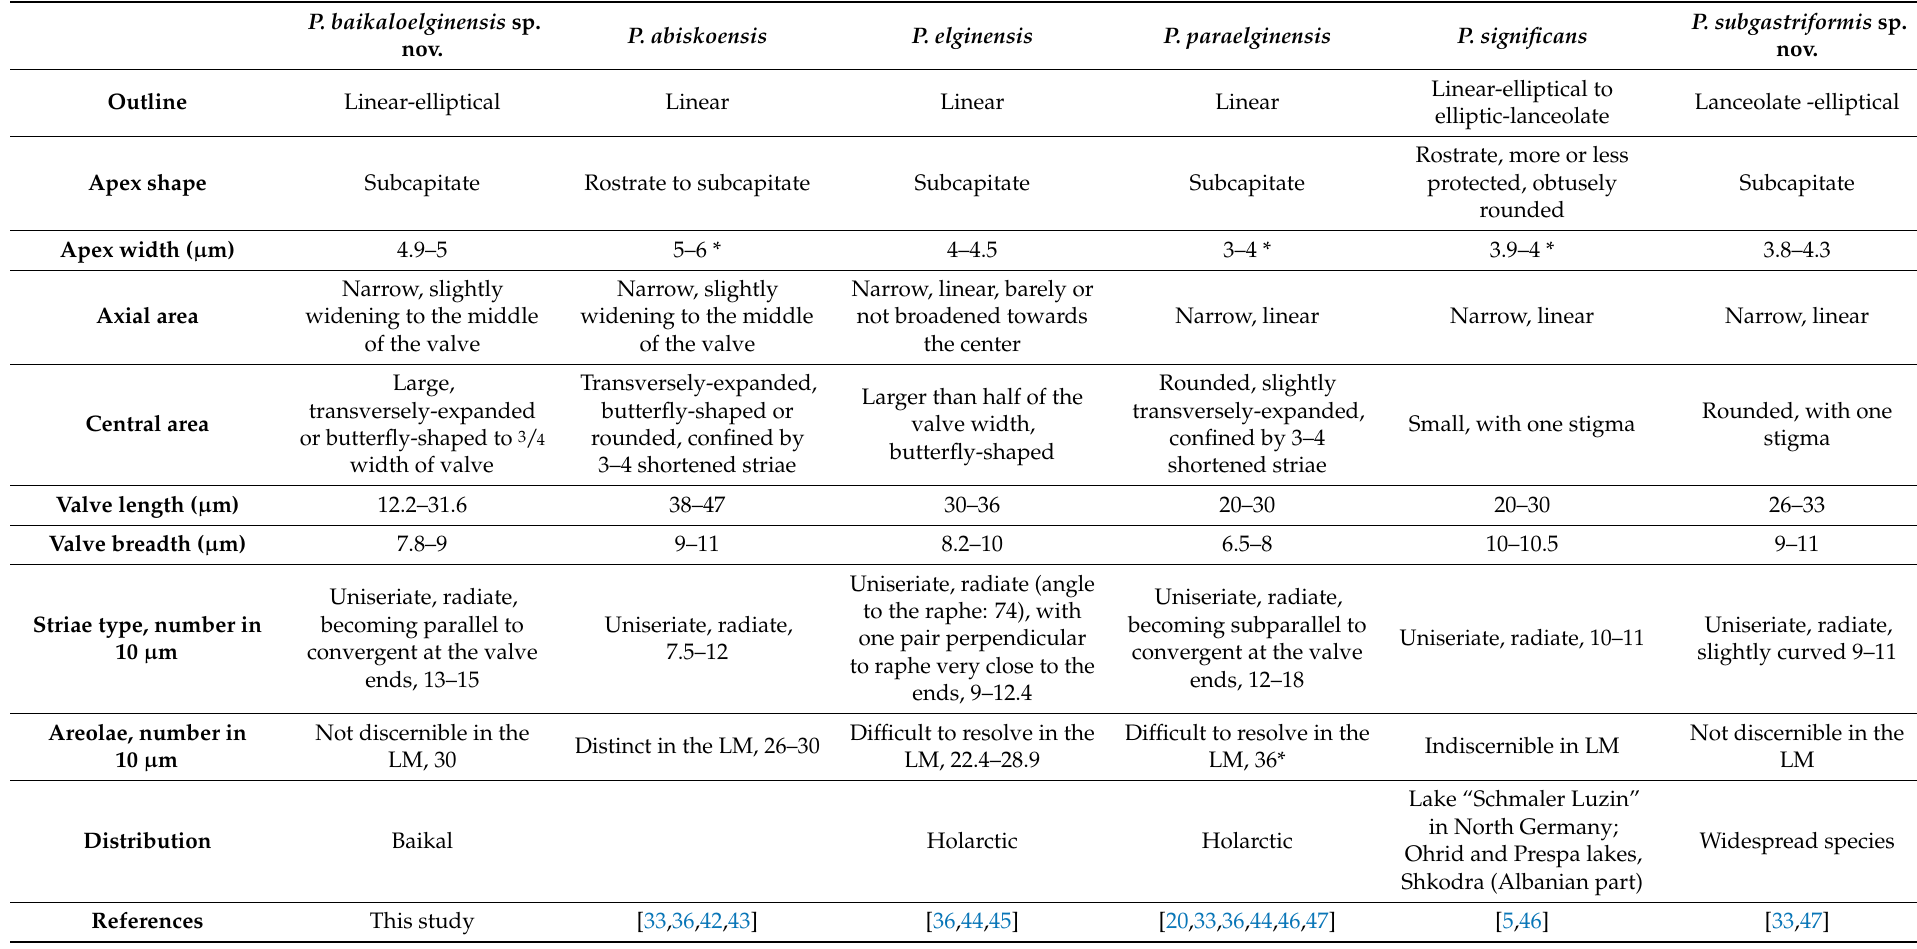
Table 2. Comparison of Placoneis baikaloelginensis sp. nov. with similar